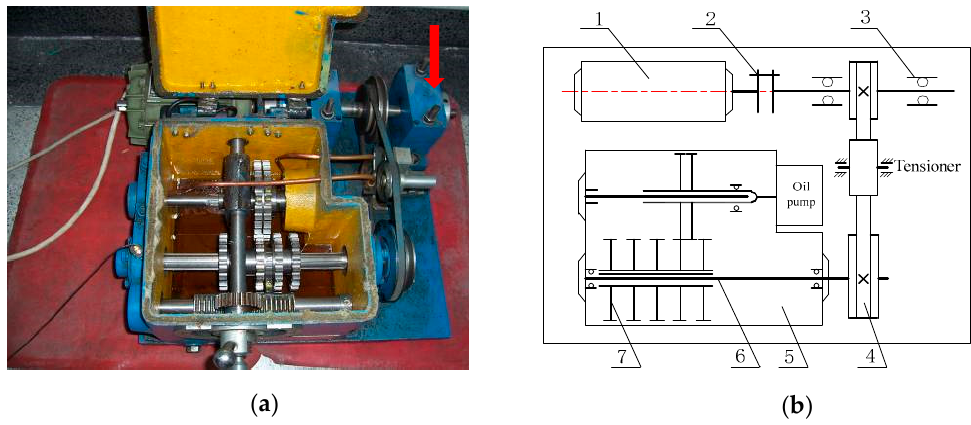
Figure 11. Bearing-gear fault test rig: ( a ) physical diagram; ( b ) structural diagram (1—AC motor; 2—coupler; 3—faulty bearing; 4—belt pulley; 5—gearbox; 6—transmission shaft; 7—gear sets).